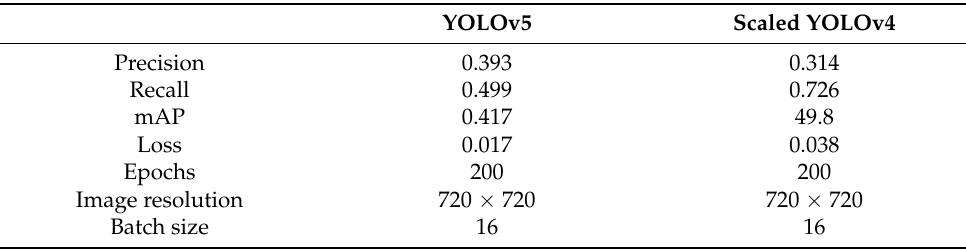
Table 4. Preliminary results for stage classification.